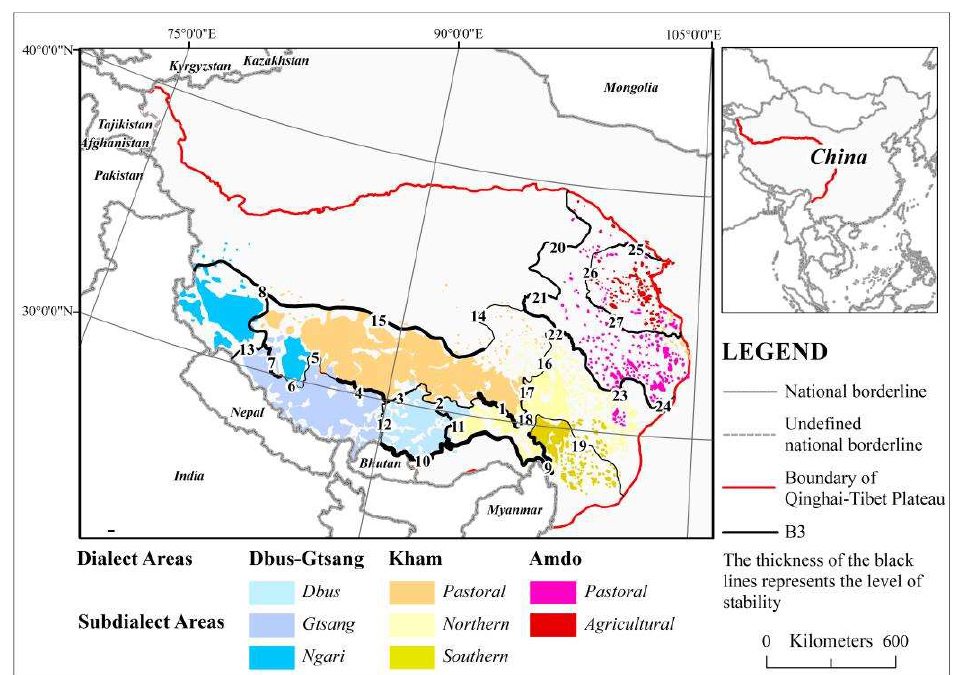
Figure 6. Segmentation of Tibetan (sub)dialect area boundaries. (Compare B3 with boundaries drawn by the Chinese Academy of Social Sciences in 2012 formed by language surveys. The positions of the two boundaries are similar, but the stability of the boundaries of each segment differs. The numbers in Figure 6 represent the serial numbers of the (sub)dialect area boundaries of each segment, corresponding to those in Table 4).